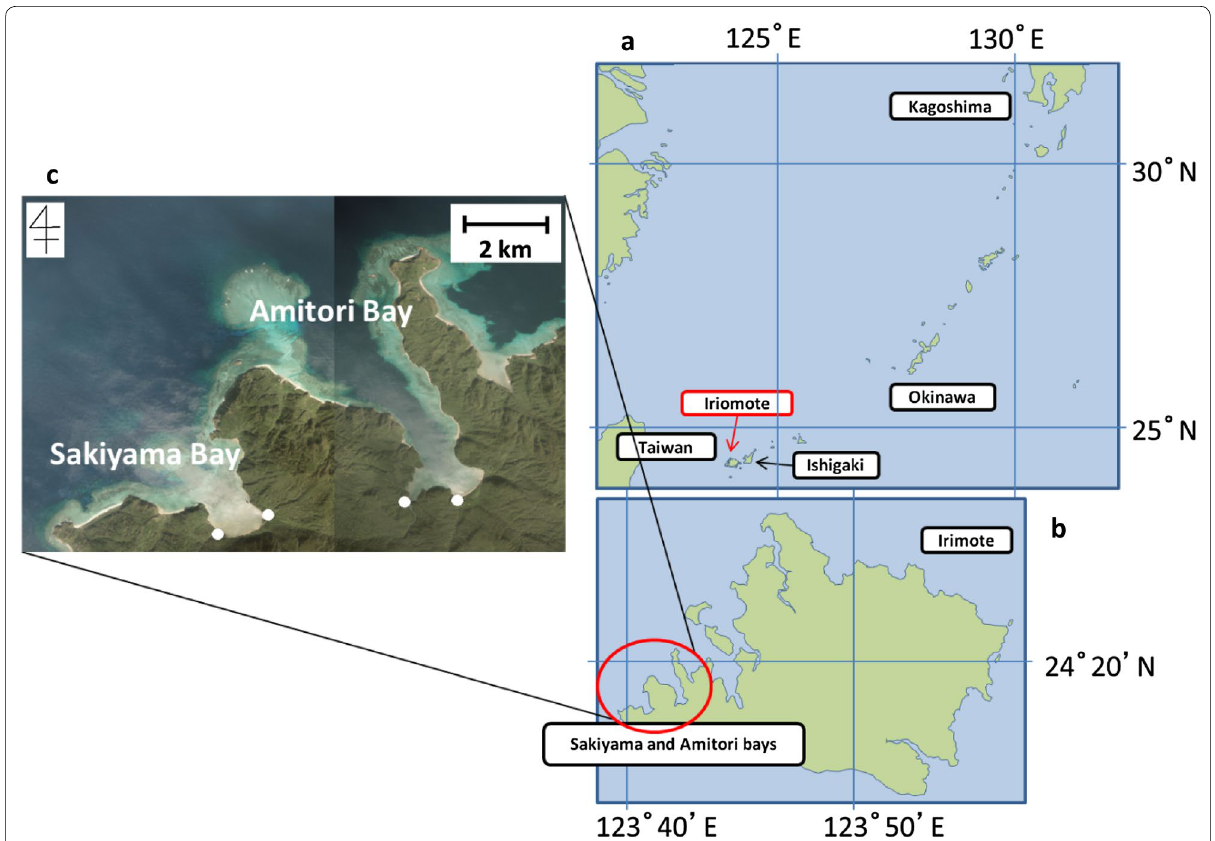
Fig. 1 The location of the study area. The study region lies towards the southernmost tip of the Ryukyu Islands, Japan ( a ) and on Iriomote Island ( b ), and consists of two bays: Sakiyama bay and Amitori bay ( c ). The white points in c show the particle released locations at the river mouths of the four rivers (see text in “Numerical model and